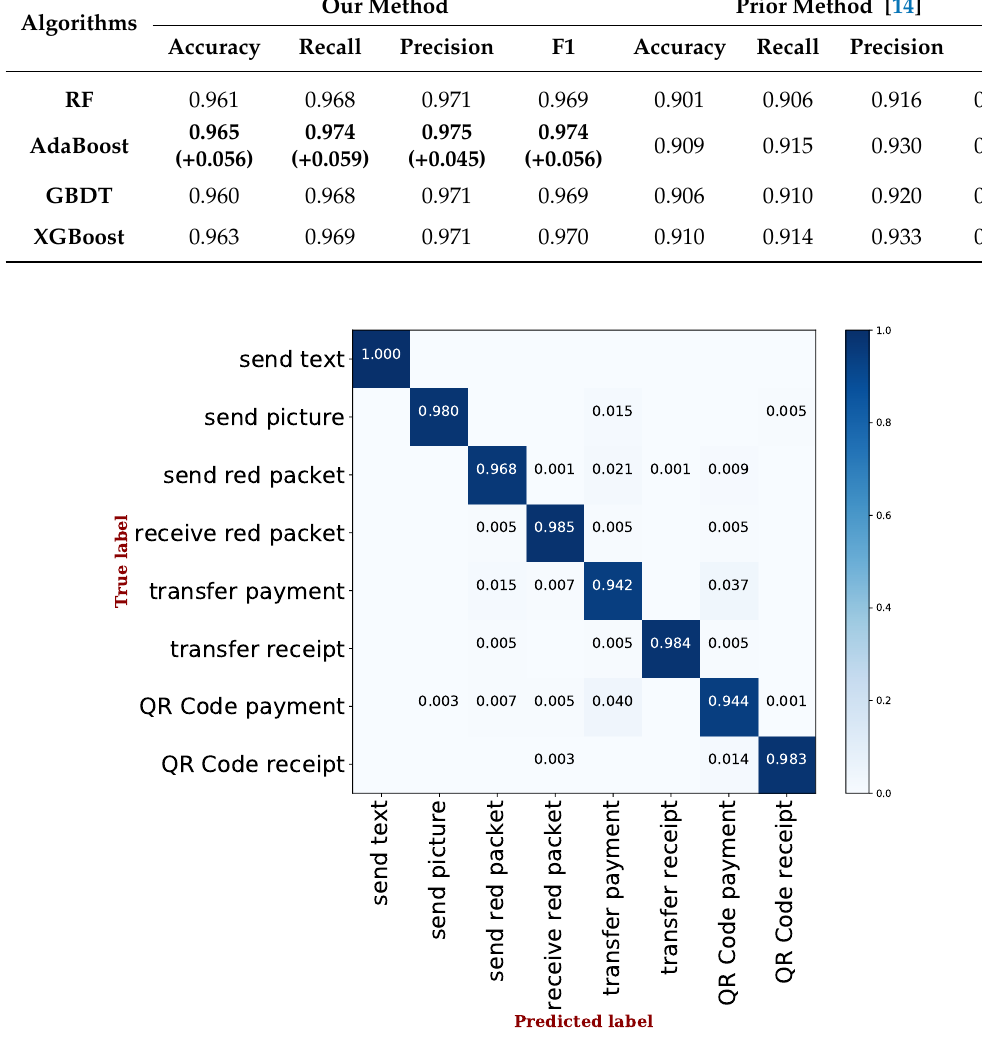
Figure 4. The confusion matrix on action identification using the AdaBoost